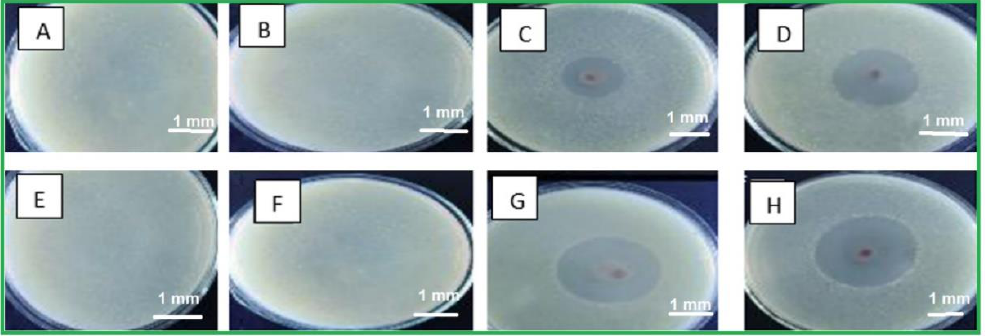
Figure 10. The inhibition zone for S1 ( A , E ), S1Ag ( B , F ), S1Ag0.3 ( C , G ), and S1Ag0.8 ( D , H